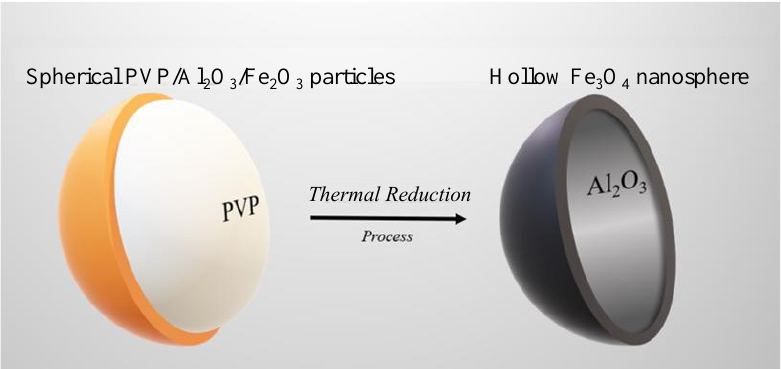
Figure 1. Scheme of the thermal reduction process that produced the calcination of the polymer and the transformation of hematite (Fe 2 O 3 ) into magnetite (Fe 3 O 4 ).